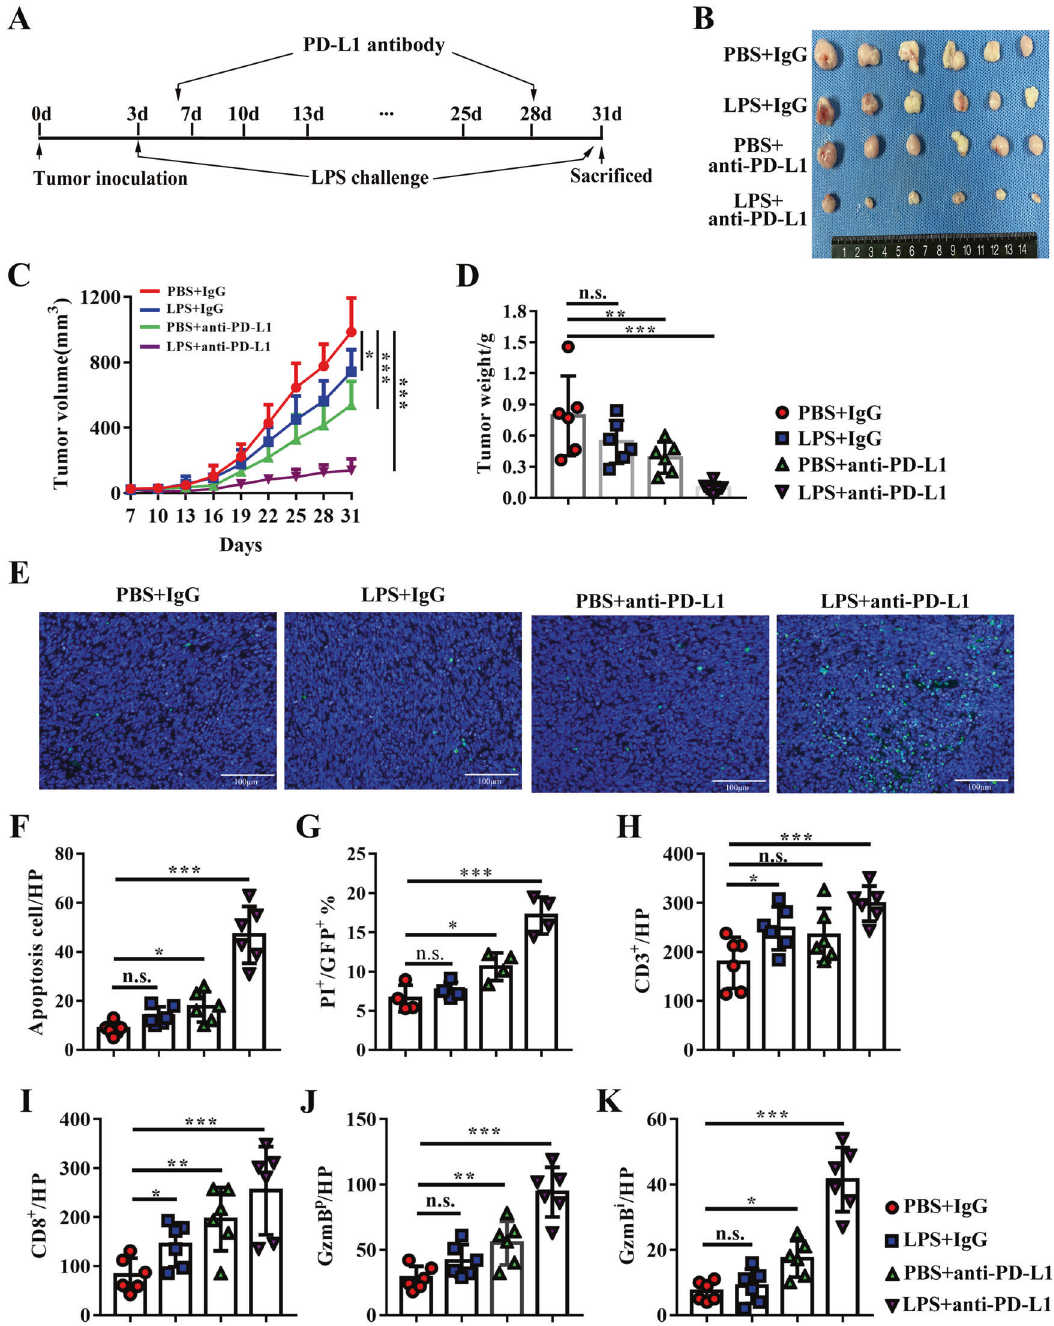
Fig. 6 LPS enhanced PD-L1 blocking therapy in PDAC murine model by promoting anti-tumor immune. A the process of LPS and anti-PD- L1 therapy animal experiment. B subcutaneous tumor derived from PBS + IgG isotype group, LPS + IgG isotype group, PBS + anti-PD-L1 group, and LPS + anti-PD-L1 group at the end of the experiments ( n = 6). Tumor growth curve ( C ) and tumor volume ( D ) of tumor derived from each group. E representative image of tunnel staining in each group to evaluate apoptotic cells. F apoptosis cell was calculated as tunnel + cells/ visual fi led. G apoptotic cancer cells in each group was evaluated by calculating the percentage of PI-positive cells in all GFP- positive cells ( n = 4). Tumor in fi ltrated CD3 + ( H ) and CD8 + ( I ) T cells were stained by immunochemistry and analyzed as positive staining number per high visual fi eld (HP). Peritumoral GzmB ( J ) and intratumoral GzmB ( K ) distribution were calculated as GzmB p /percentage of the peritumoral area or GzmB i /percentage of peritumoral area in a visual fi eld, separately. *, **, *** and n.s. means statistically signi fi cant difference at p < 0.05, p < 0.01, p < 0.001 and no signi fi cant,